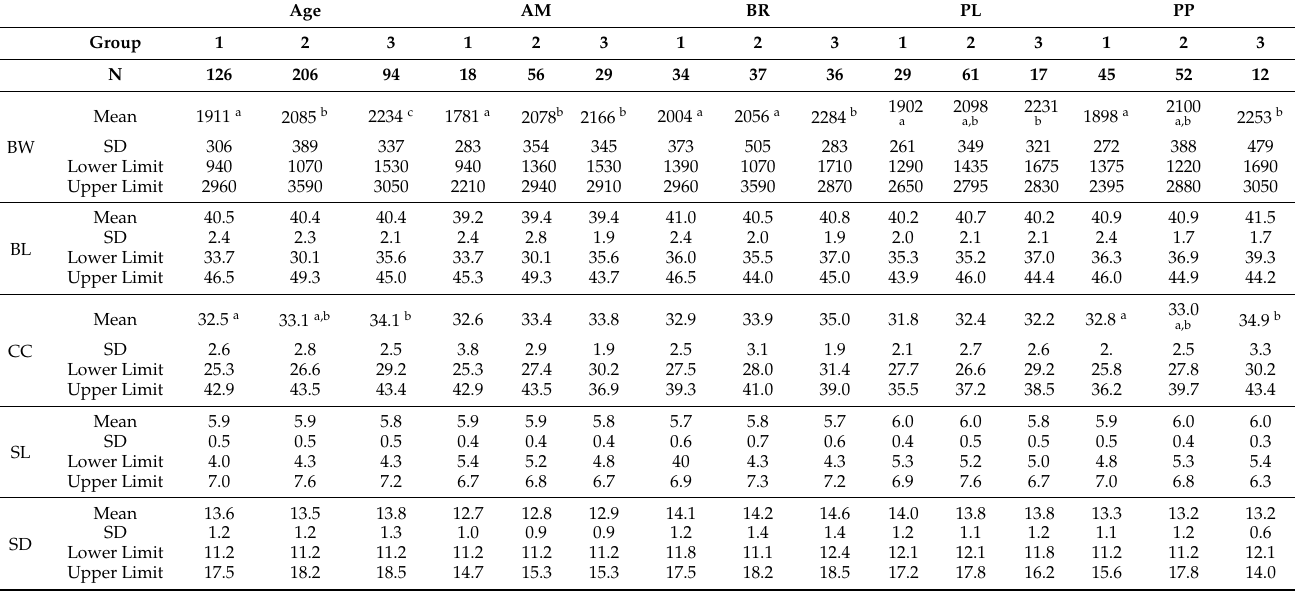
Table 4. Effects of age group and breed in the different zoometric measures (cm) and body weight (g) in hens. Age AM BR PL